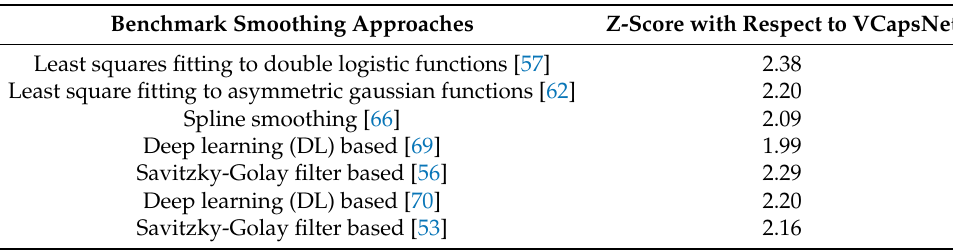
Table 8. Z-score-based significance analysis of the results of VCapsNet